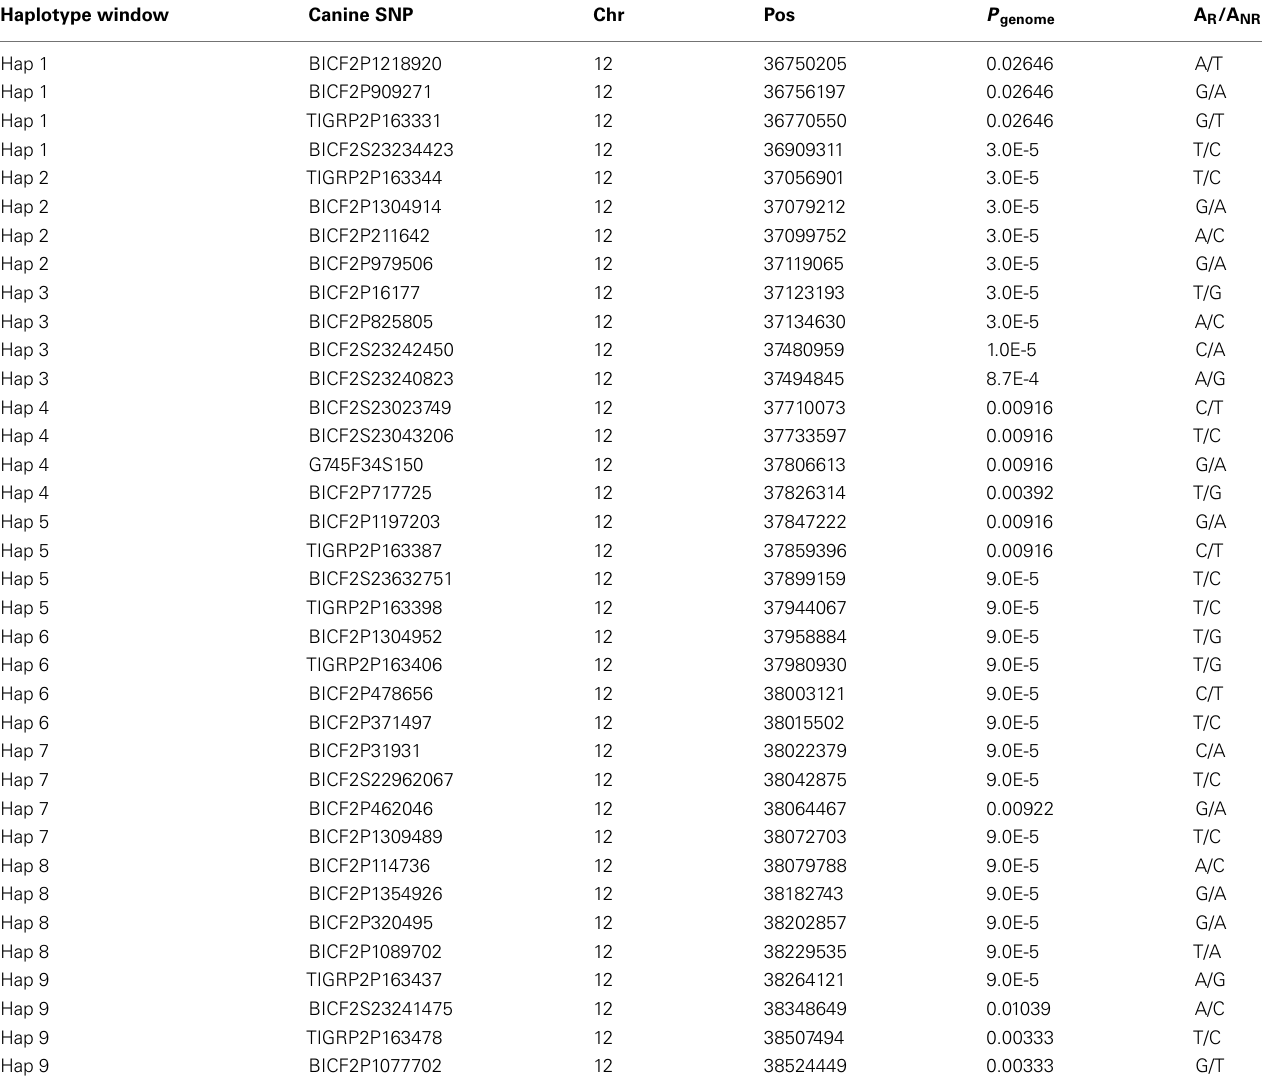
TableA4 |Top allelic association hits in the GWAS on disc calcification in 33 wire-haired cases and 28 wire-haired controls, sorted by genomic